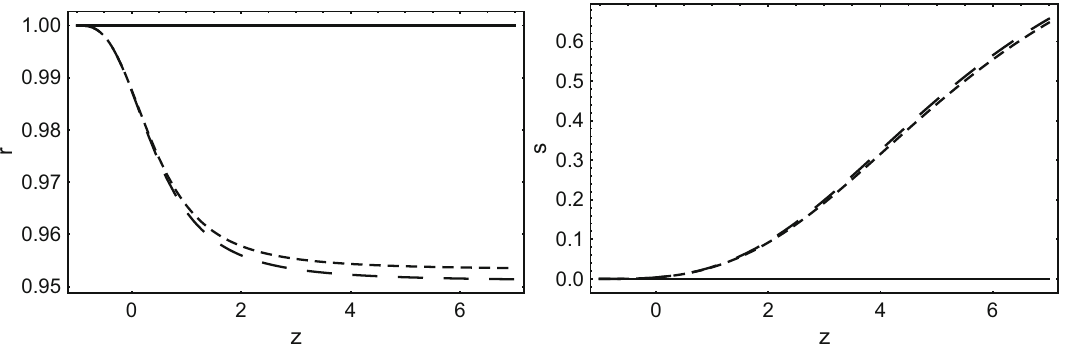
Fig. 5 It is depicted the behaviour of the statefinder parameters r (left panel) and s (right panel) as functions of redshift z , for ν m = 0 . 01, and ν G = 5 × 10 − 4 (short-dashed line) and the second ν G = 1 × 10 − 3 (large-dashedline).Solidlinerepresentsthevaluesof r and s for (cid:2) CDM